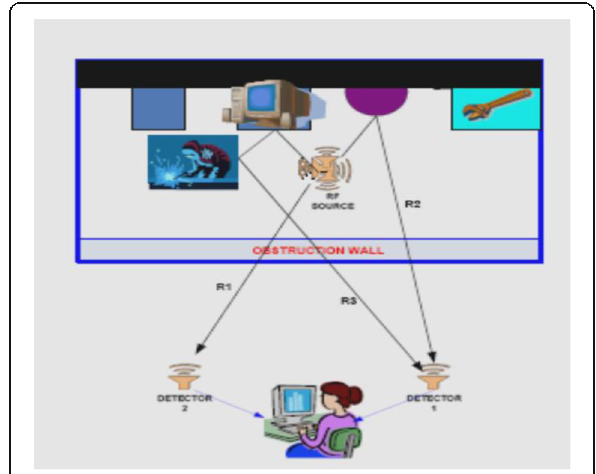
Fig. 2 Back scattering paths of electromagnetic waves to the detectors